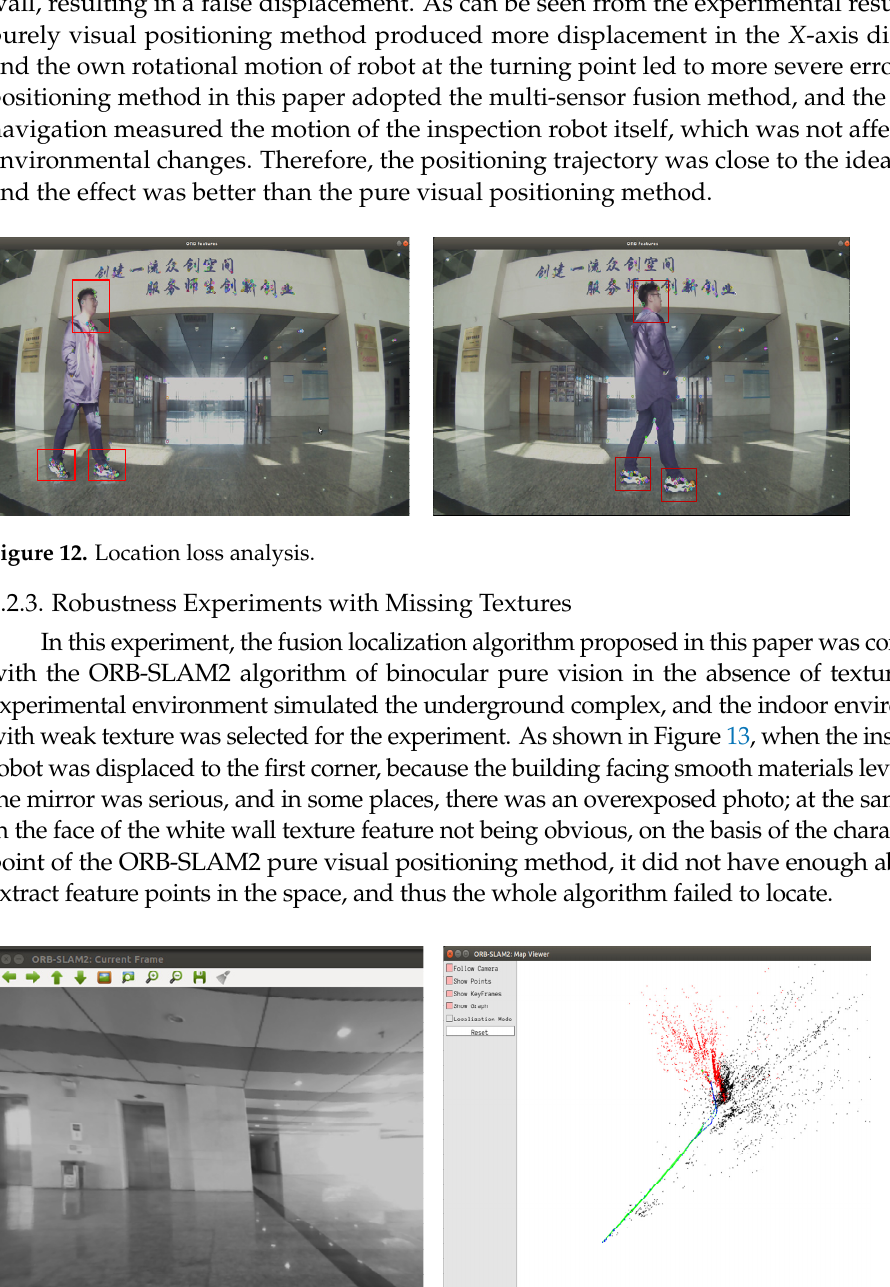
Figure 14. Localization results of algorithm in the paper in a low-texture environment. 5. Conclusions In this paper, the traditional visual SLAM algorithm was improved for the character- istics of large personnel flow and sparse background texture in an underground complex. In order to solve the problem that it is difficult for the front end to extract feature points from weak texture and the tracking is easy to be lost, the Harris algorithm with a stronger ability to extract feature points was introduced, which was combined with optical flow pyramid tracking to enhance the robustness of the visual positioning system. Various er- ror sources of IMU were analyzed, and the performance of the Euler method and median method on dynamic model discretization was compared through simulation, and the Eu- ler method with shorter time consumption was selected. Finally, the non-uniform rational B-spline was used to solve the problem of the non-synchronization of sensors with differ- ent frequencies, and the tight coupling between the vision sensor and IMU was realized. In the real physical environment, the research group simulated the environment of an urban underground complex, and the experiment showed that the fusion algorithm pre- sented in this paper had better experimental results in terms of positioning accuracy, anti-